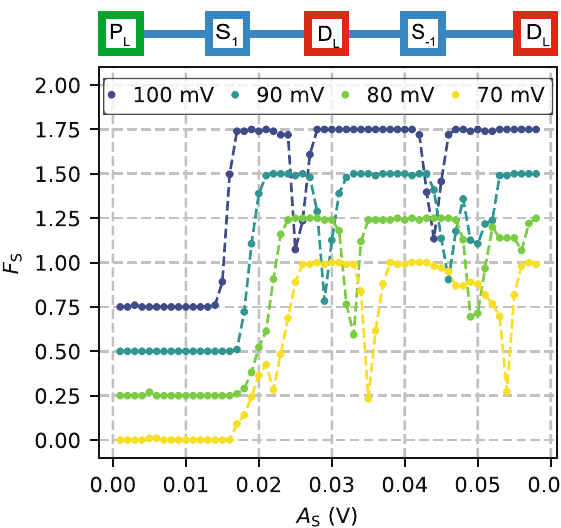
Fig. 4 Shuttle fi delity. The pulse sequence is depicted above the panel. The shuttle fi delity as a function of shuttling amplitude for different voltage offsets Δ B S between the two different gate layers (P and B gates) with fi xed f = 1 kHz and B S = 730 mV. The electron is loaded on the left, shuttled to the right by a distance of λ , a detection segment is applied, the electron is shuttled back to the left and a second detection segment is applied. We capture the success probability P as a function of the shuttling amplitude A S and different offsets between the gate layers Δ B S . The shuttling sequence is counted as successful if the fi rst D L detects no electron and the second one does detect an electron. The curves are offset by 0.25 for clarity and solid lines are guides-to-the